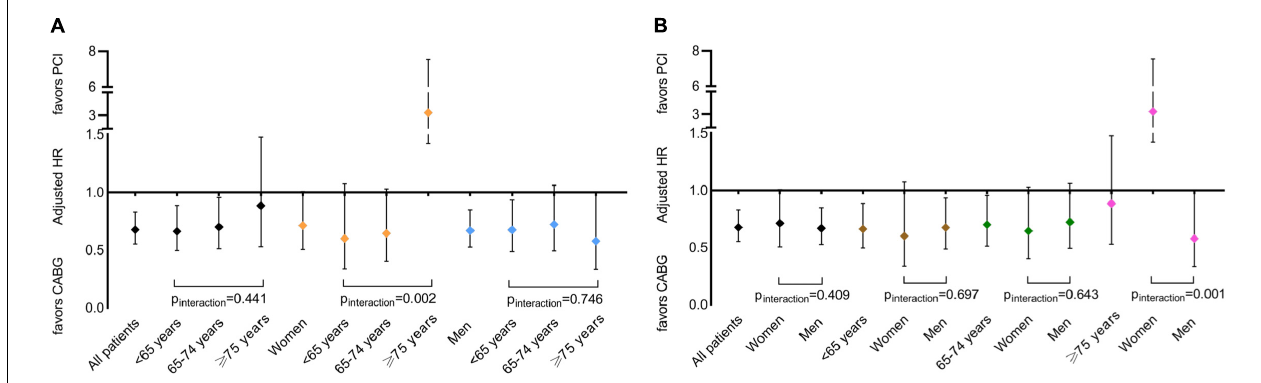
FIGURE 3 | Effect of CABG relative to PCI on MACCE by age categories (A) and sex groups (B) . PCI, percutaneous coronary intervention; CABG, coronary artery bypass grafting; and MACCE, major adverse cardiovascular and cerebrovascular event.